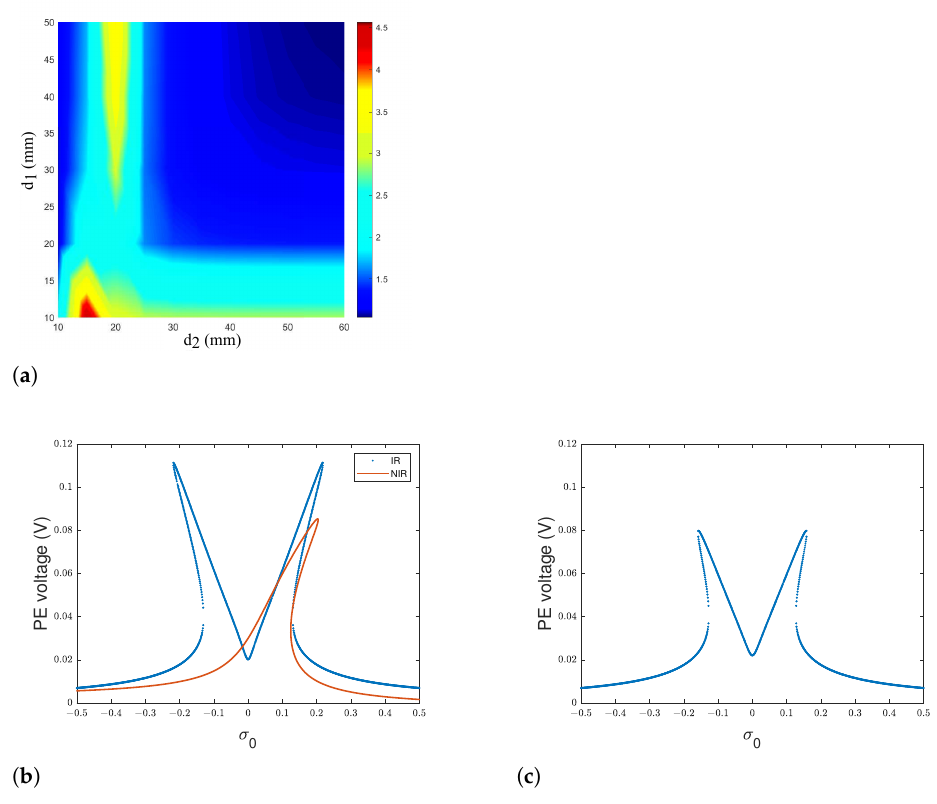
Figure 2. ( a ) Ratio ω 2 / ω of the natural frequency ω 2 to ω 1 while varying the gaps d 1 and d 2 ( b ) 1 piezoelectric voltage response curve around the 1st primary resonance for an Internally Resonant (IR) harvester and case of a Non-Internally-Resonant (NIR) harvester; ( c ) voltage response curve around the 2nd primary resonance for IR